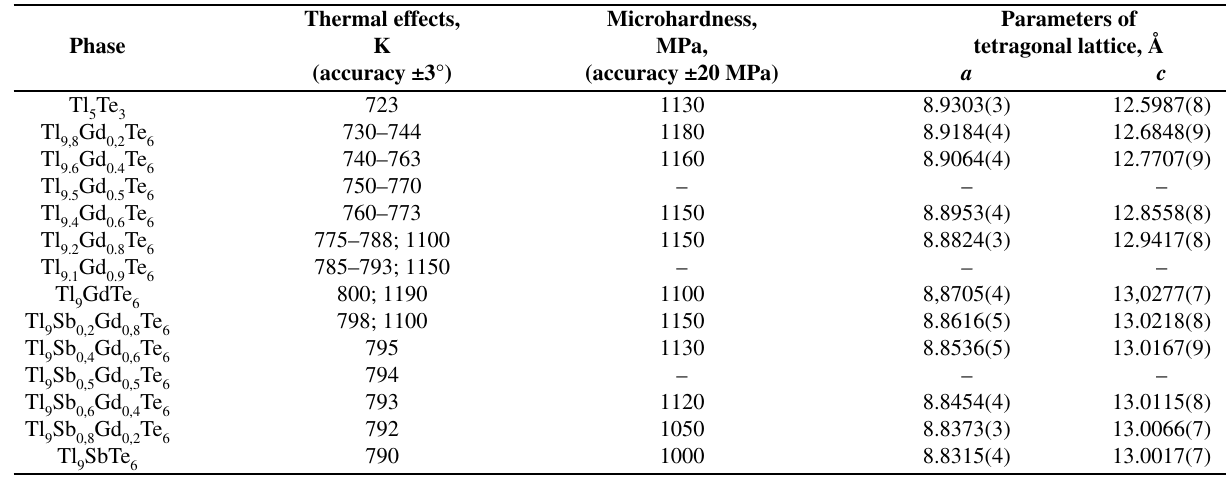
Te -Tl SbTe -Tl GdTe system. 5 3 9 6 9 6